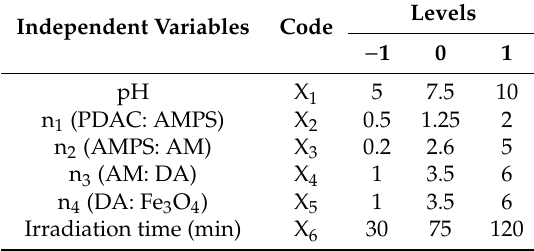
Table 1. The independent variables levels designed in the B 54 (3 6